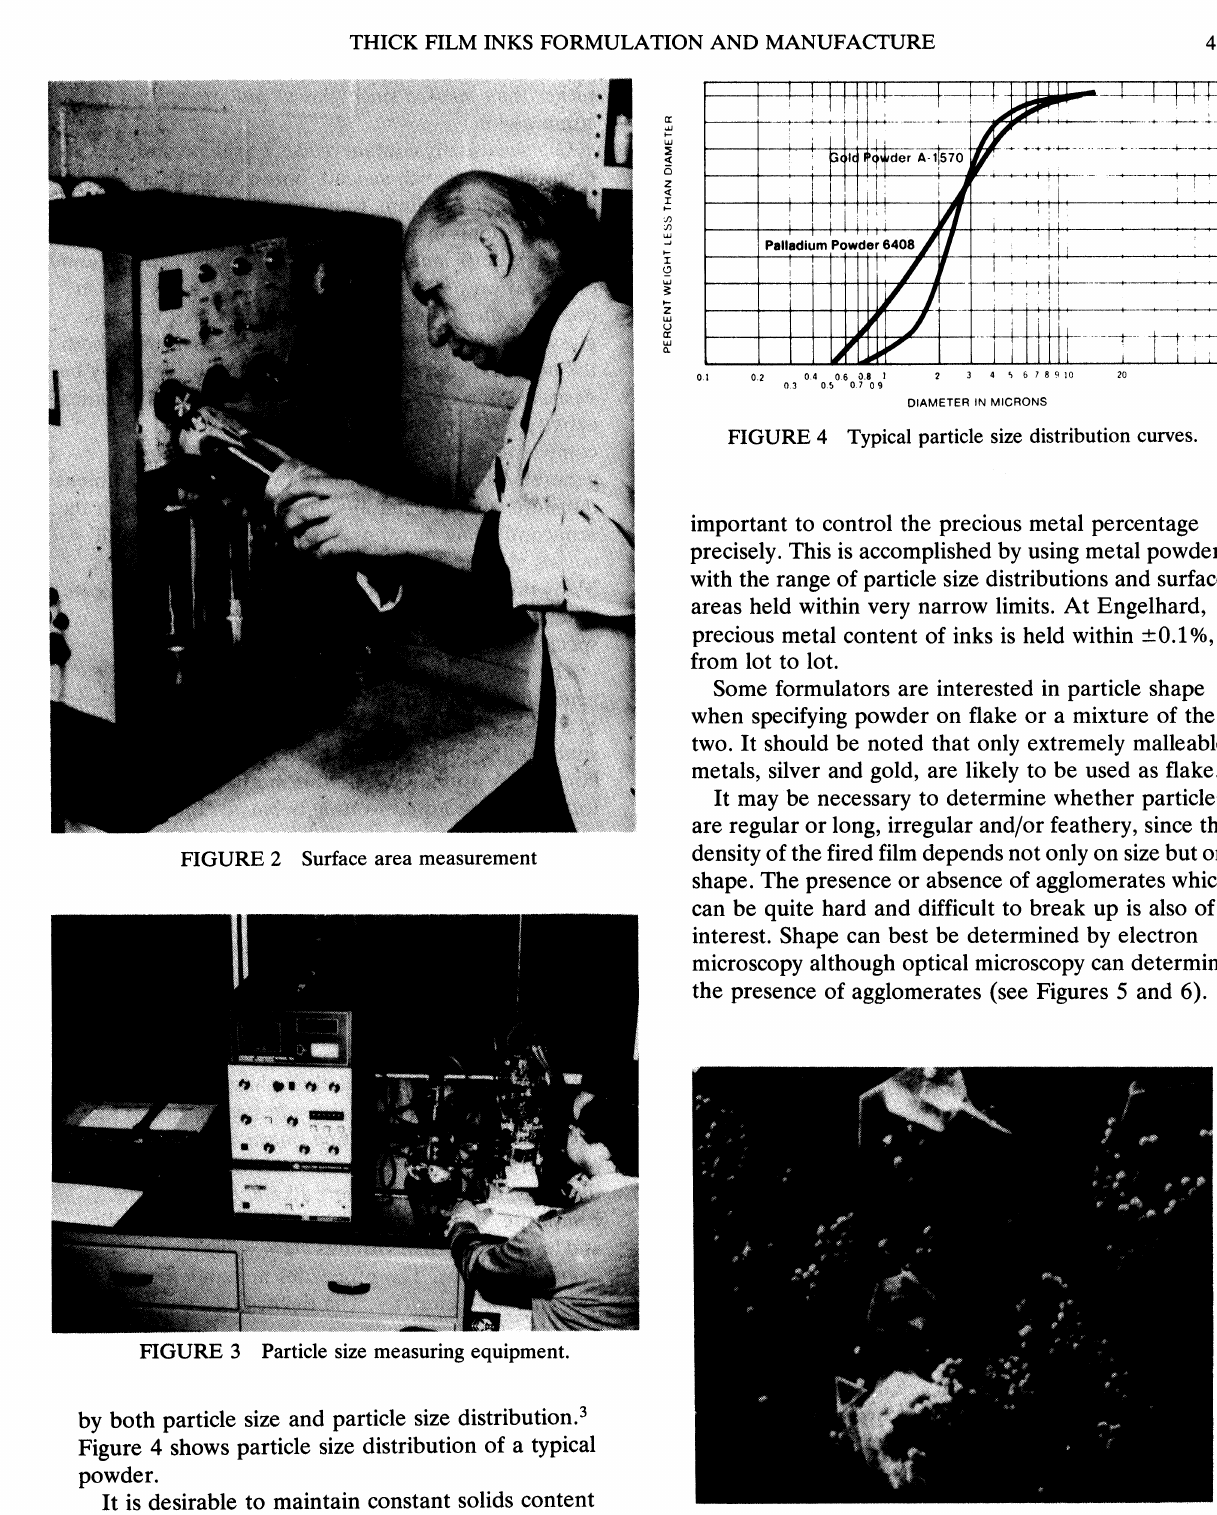
FIGURE 3 Particle size measuring